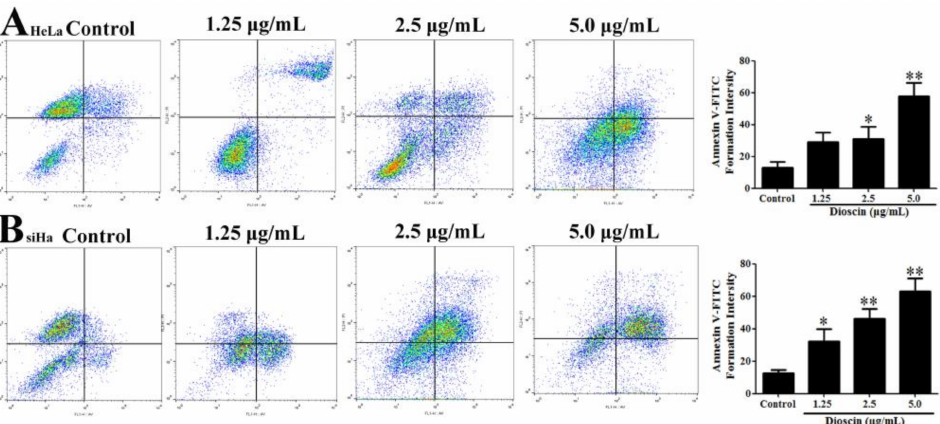
Figure 8. Dioscin induced HeLa and SiHa cell apoptosis. ( A ) Dioscin caused apoptosis in HeLa cells by flow cytometric analysis with Annexin V-FITC and PI-staining; ( B ) Dioscin caused apoptosis in SiHa cells by flow cytometric analysis with Annexin V-FITC and PI-staining. Data are presented as mean ˘ SD ( n = 3). * p < 0.05 and ** p < 0.01 compared with control group. Molecules 2016 , 21 , 730